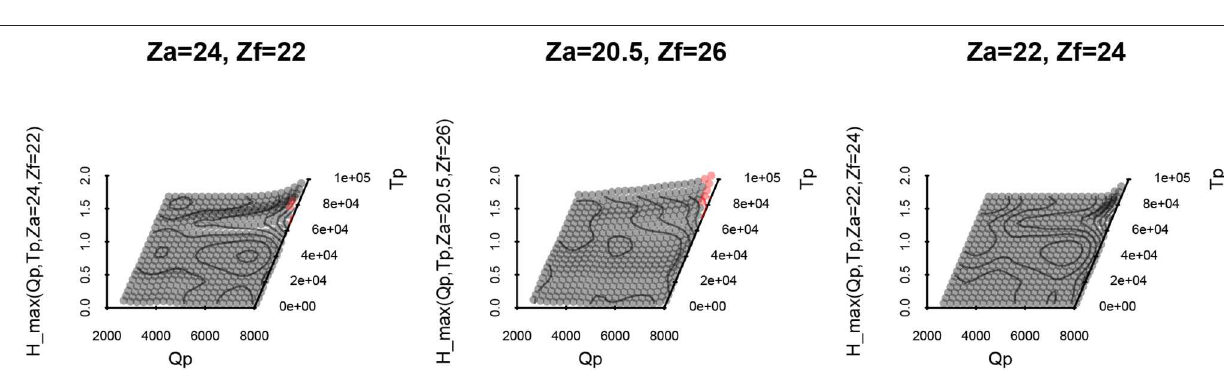
FIGURE 7 | Metamodel mean response surface on S u for surely unsafe points.